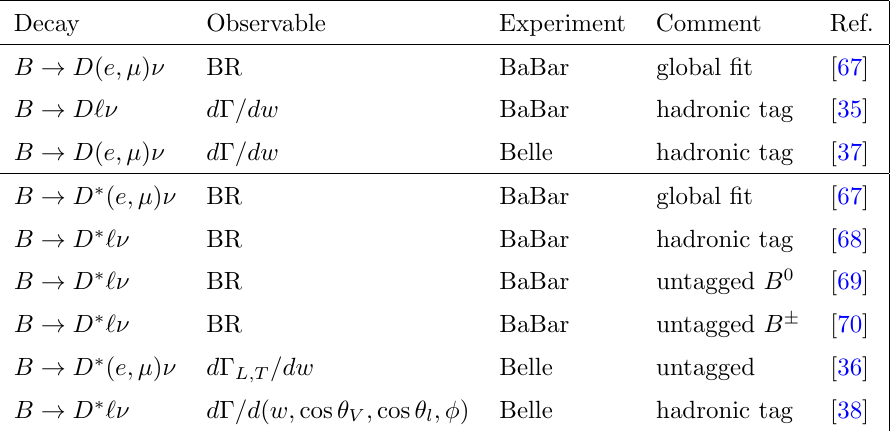
D ( (cid:3) ) ‘(cid:23) do not di(cid:11)erenti- !